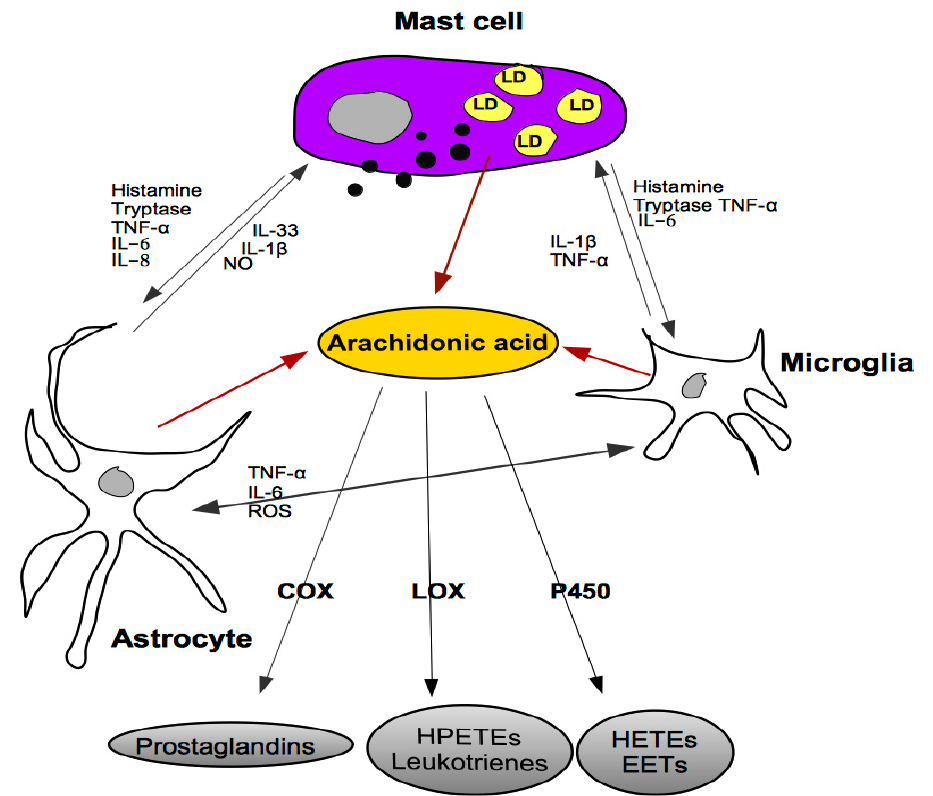
Figure 1. Cross-talk between mast cells, astrocytes, and microglia as arachidonic acid sources. The black dots in mast cells are the typical granules containing preformed molecules. COX, cyclo-oxygenase; EET, epoxyeicosatrienoic acid; HETE, hydroxyeicosatetraenoic acid; HPETE, hydroperoxyeisosatetraenoic acid; IL-, interleukin-; LOX, lipoxygenase; NO, nitric oxide; LD, lipid droplet; P450, cytochrome P450 epoxygenase; ROS, reactive oxygen species; TNF- α , tumor nerve factor- α .